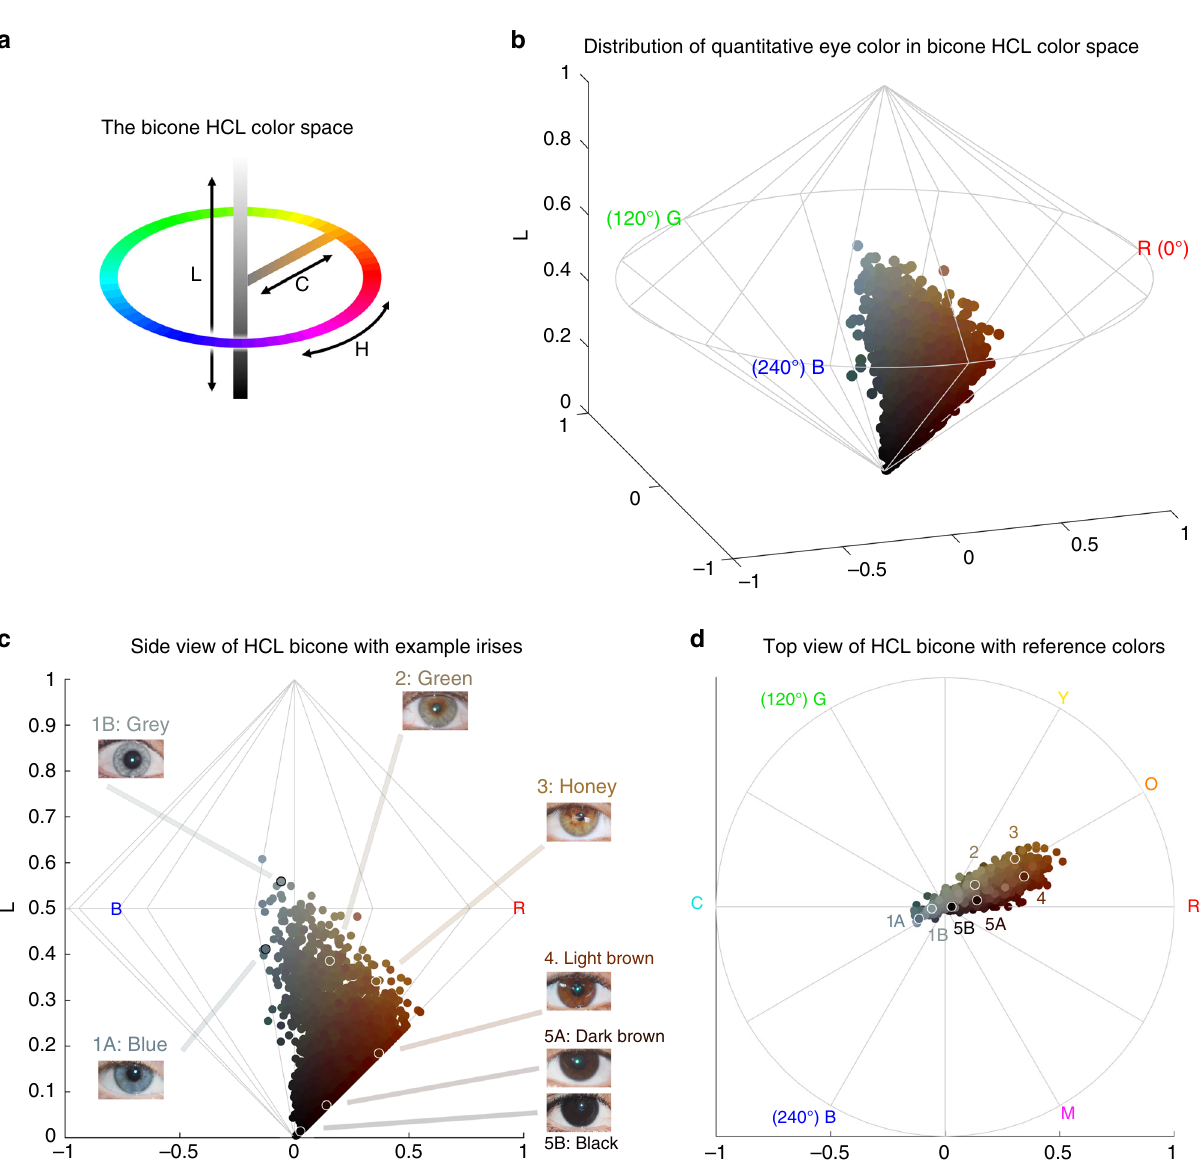
Fig. 2 Quantitative assessment of eye pigmentation in the CANDELA sample. a Three-dimensional distribution of quantitatively assessed iris colors in the bicone HCL (hue, chroma, lightness) color space. Each dot corresponds to a CANDELA individual and its color represents the average iris color for that person. The color space has a polar coordinate system, where the vertical axis represents L (lightness/brightness, from dark = 0 to light = 1), the horizontal distance from the central axis represents C (chroma/saturation, from desaturated = 0 to fully saturated = 1), and H (hue/ tone) represents the angle when a vertical plane is rotated along the central axis (the three primary colors red (R), green (G) and blue (B) being situated at angles of 0°, 120° and 240° respectively). b The full range of the HCL color space, showing how the three color components vary in the space. Hue varies as a color circle, coming back to red at 360°. The unlabeled axes represent the Cartesian equivalents for the C and H variables, which de fi ne a polar coordinate system, as shown in panel a . c Side view of the bicone in a showing how the L (lightness/brightness) and C (chroma/saturation) of eye colors vary among CANDELA volunteers. The position of the dots corresponding to the average eye colors of the sample images in Fig. 1c are indicated. d Top view of the bicone in a showing how H varies among the eye colors of CANDELA volunteers. The position of the dots corresponding to the average color of the sample images in Fig. 1c are highlighted by white circles. In addition to the primary RGB colors, the secondary colors orange (O), yellow (Y), cyan (C) and magenta (M) are shown at their corresponding H